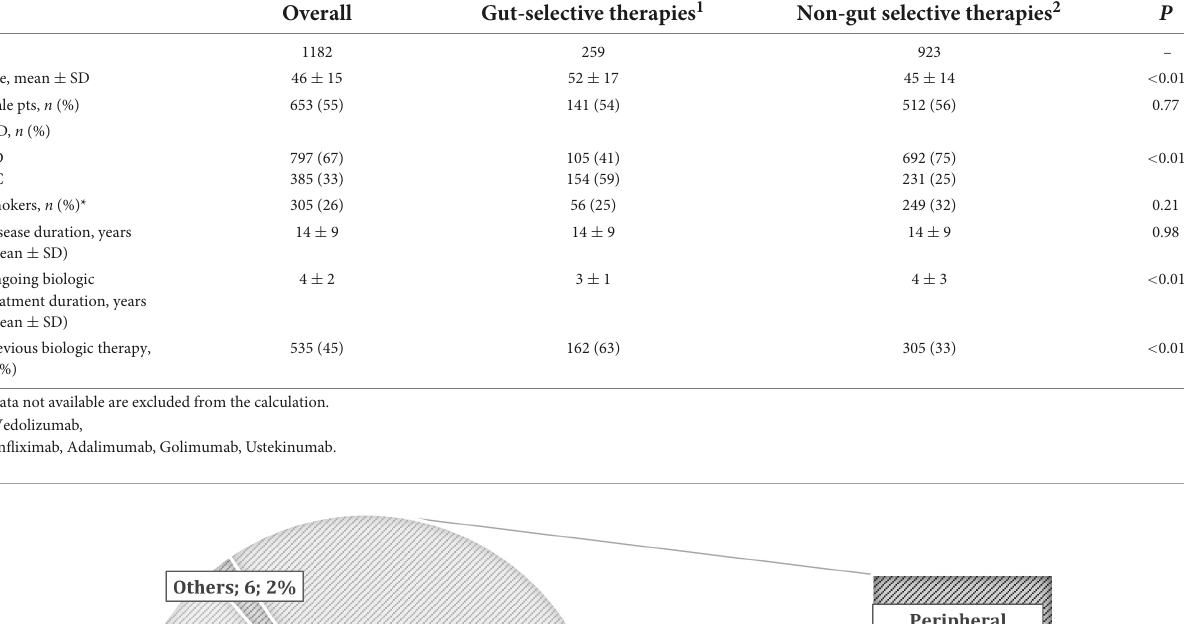
TABLE 1 Demographic and clinical parameters of included patients.